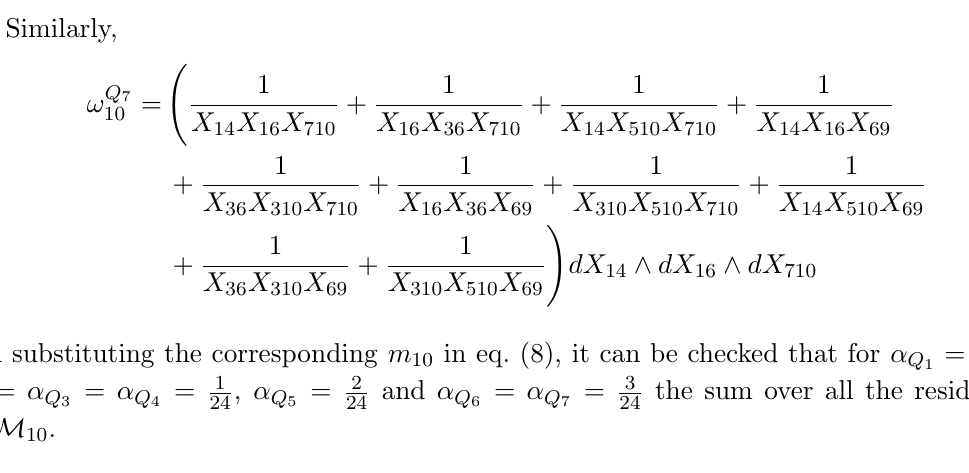
Figure 20 . In the mixed case the corresponding polytope has 10 vertices, 15 edges and 7